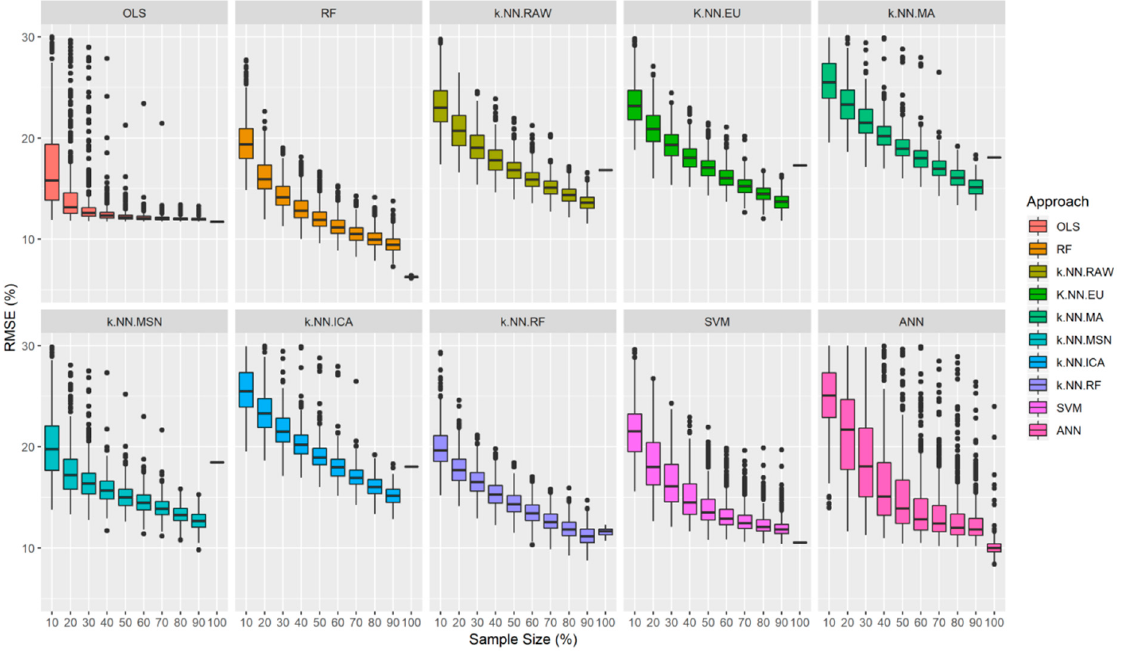
Figure 4. Modeling methods’ performance measures in terms of relative root mean square error— (RMSE%), derived from the 500 bootstrapping simulations for each sample size.